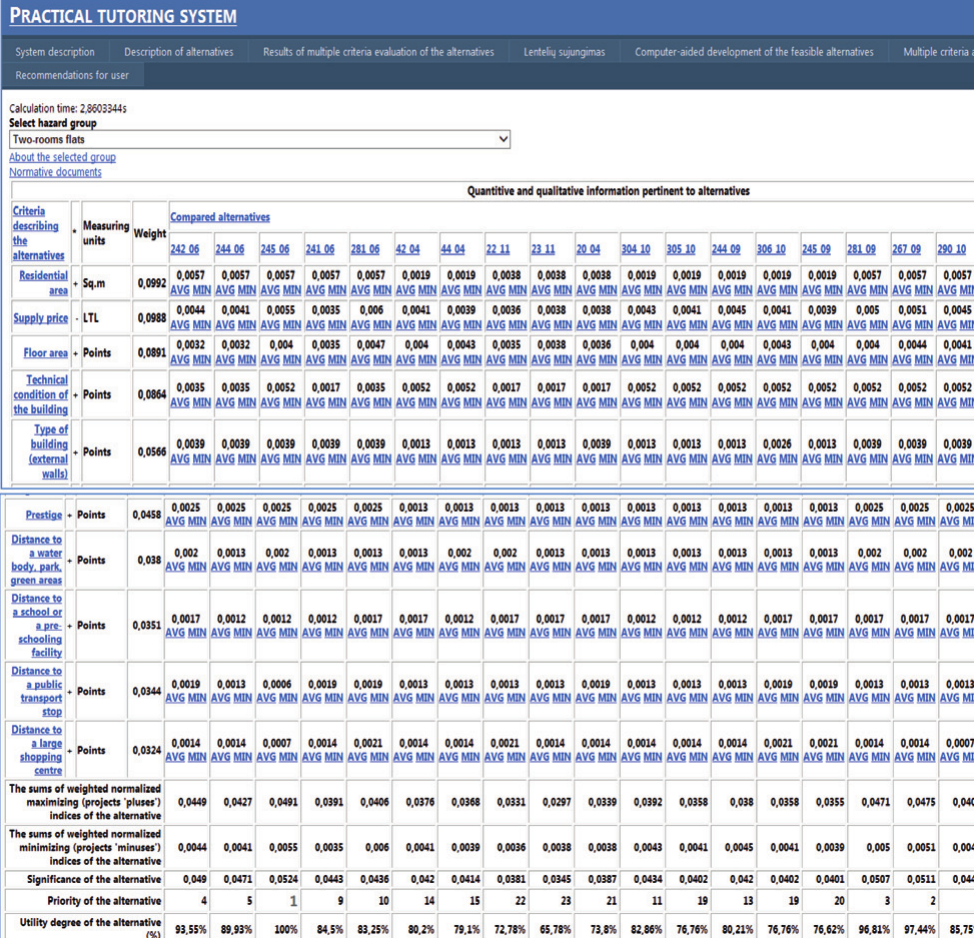
Fig. 4. Example of multiple criteria evaluation of the flats (the first lines and the last lines of the matrix with the